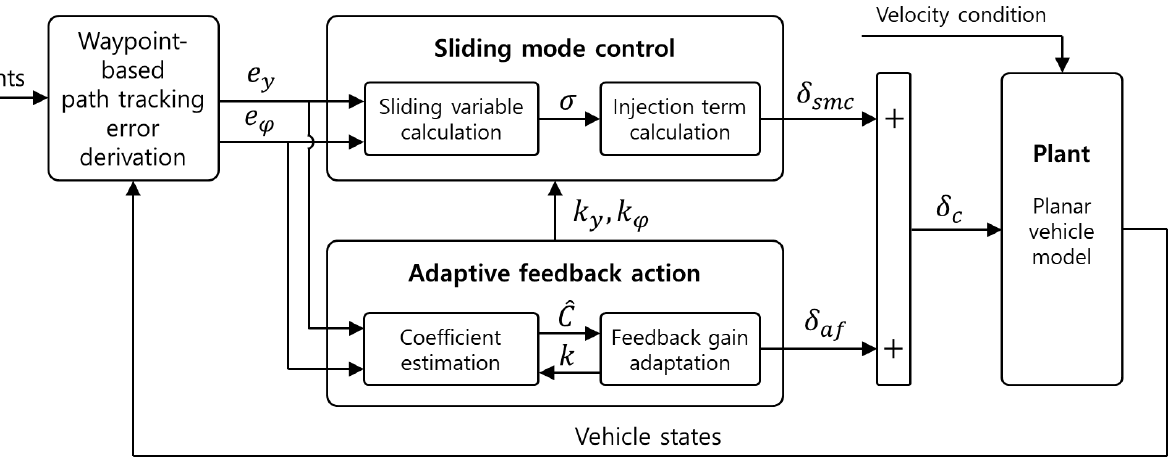
Figure 4. Overall block diagram for performance evaluation of the control algorithm.